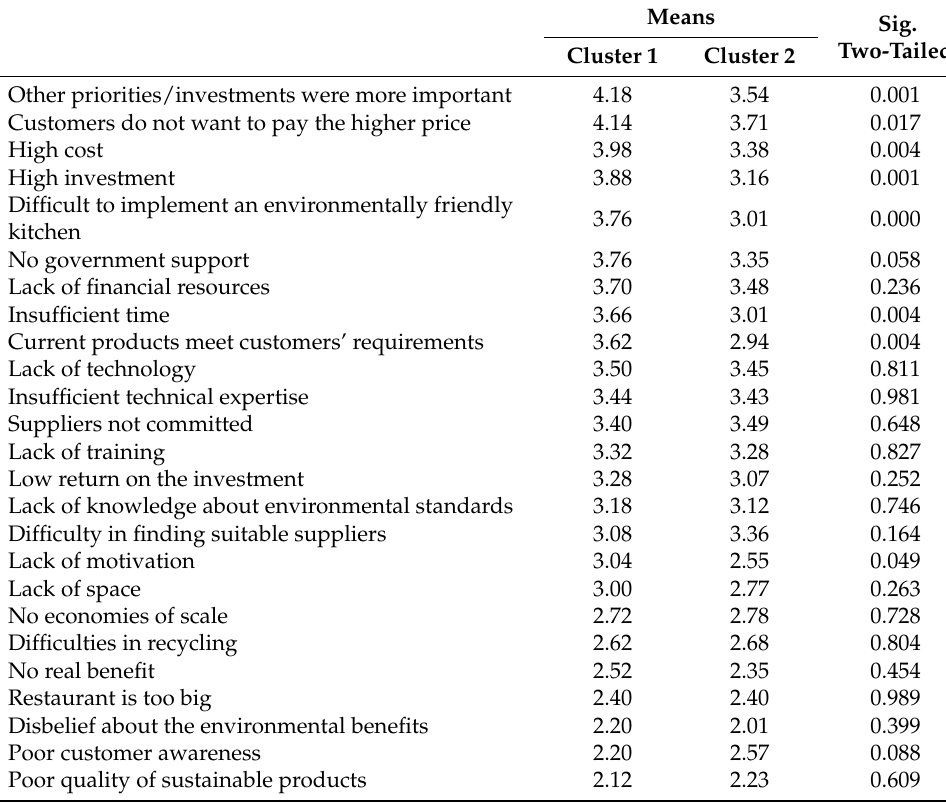
Table 6. Barriers to the adoption of sustainable